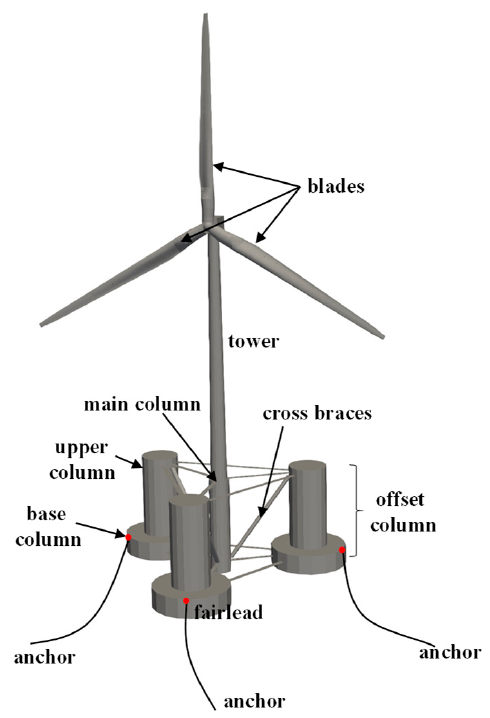
Figure 4. Sketch of the original OC4 model. Table 2. Platform properties in OC4.